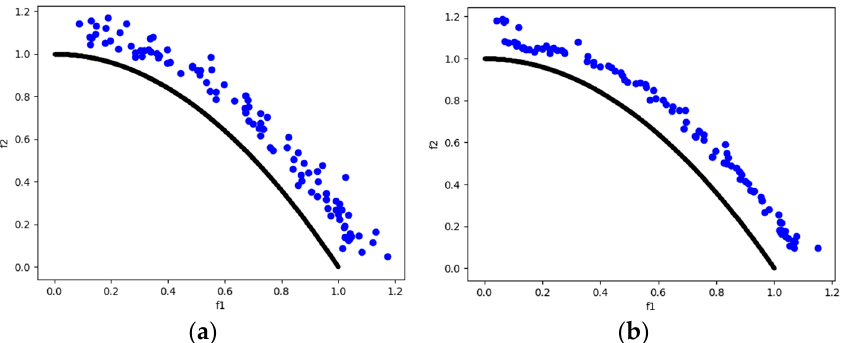
Figure 12. The plots of the approximate PFs with the highest HV value against real PF. ( a ) UF4 approximate PF using MOSA/D-CGO; ( b ) UF4 approximate PF using MOSA/D-DE.